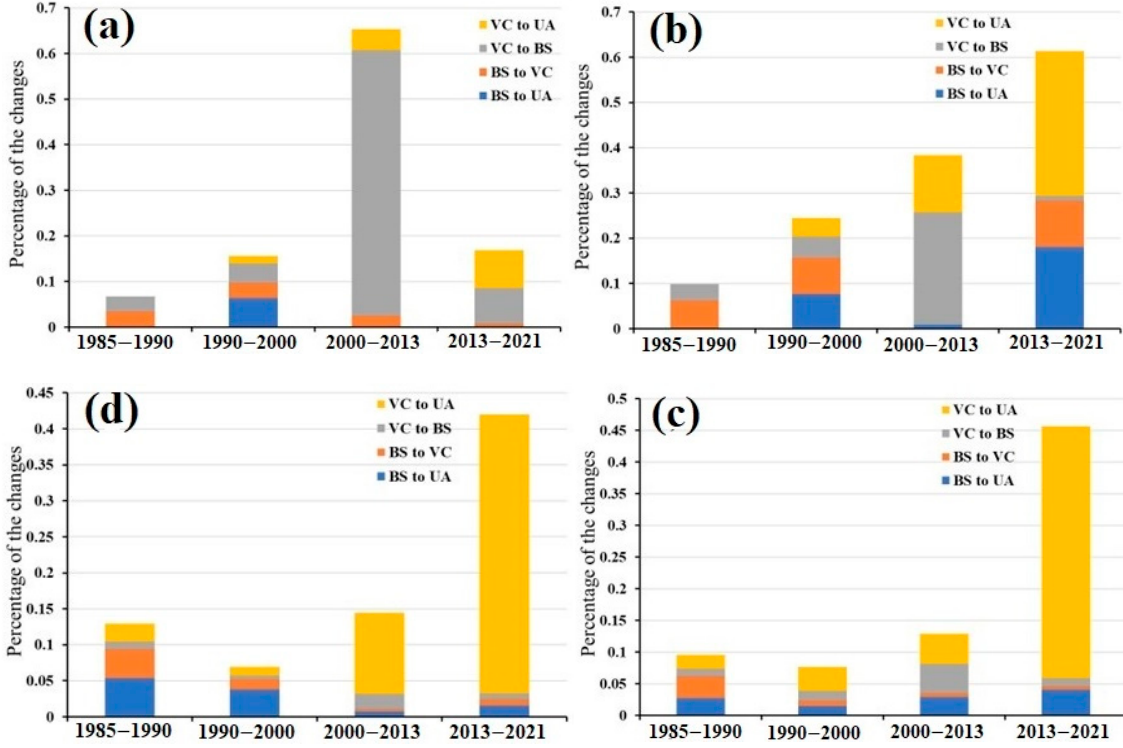
Figure 17. Percentage of LULC changes from vegetation cover/land farms (VC) to urban area (UA), VC to bare soil (BS), BS to VC, and BS to UA in Falaj Al-Khatmeen, Falaj Al-Maliki, Falaj Al-